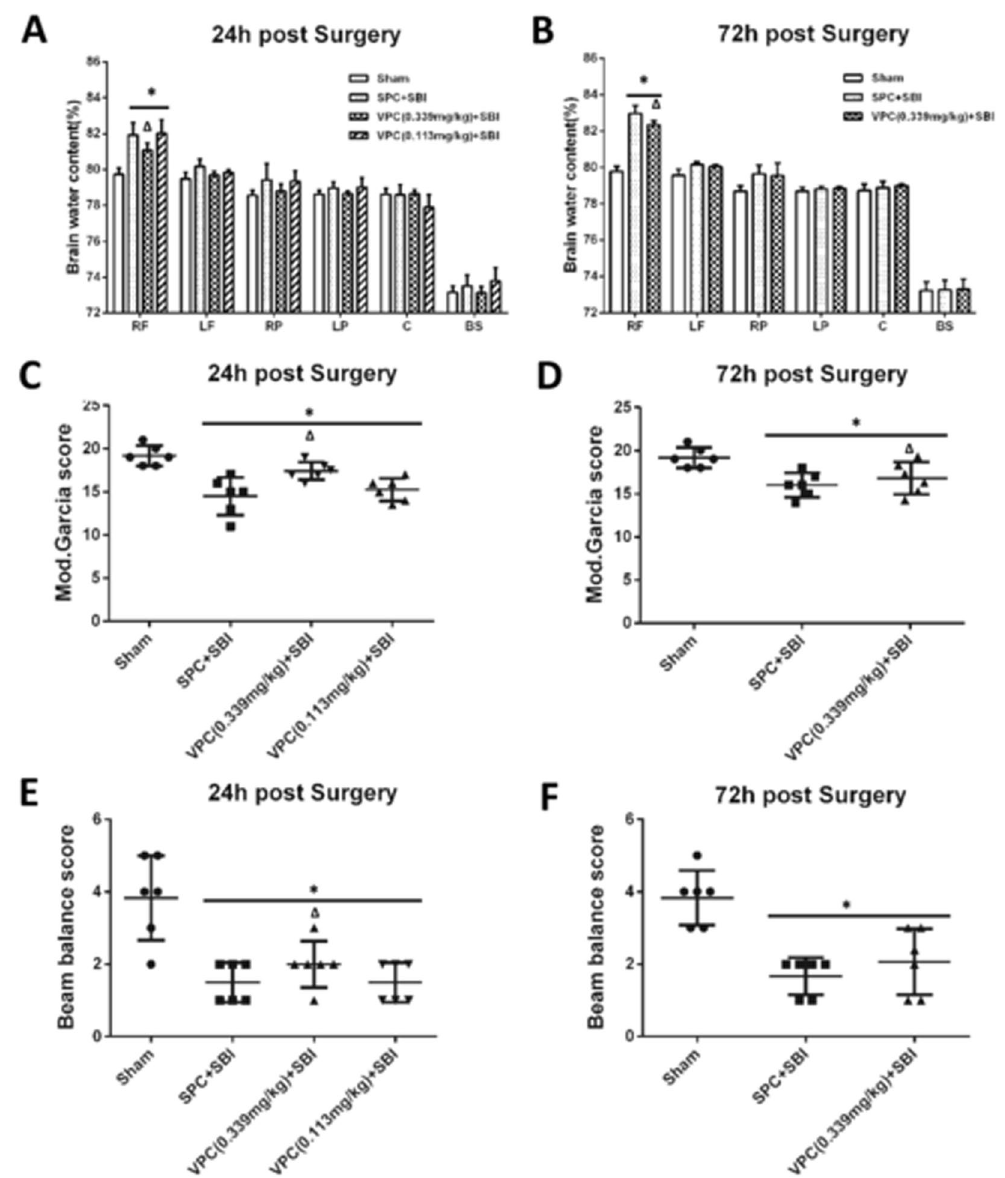
Figure 1. Effects of venom preconditioning (VPC) on brain water content and neurological function 24 h and 72 h after SBI. (A and B) VPC (0.339 mg/kg) decreased brain water content at the right frontal (RF) peri- resection brain tissue 24 h and 72 h after SBI, respectively. (C and D) VPC (0.339 mg/kg) improved modified Garcia neurological score 24 h and 72 h after SBI, respectively. (E) VPC (0.339 mg/kg) improved beam balance neurological score 24 h after SBI. (F) VPC (0.339 mg/kg) showed a trend to improved beam balance score 72 h after SBI. * p < 0.05 vs Sham, ∆ p < 0.05 vs SPC + SBI. Data are shown as mean ± SD. n = 6–8/group. RF = right frontal lobe, LF = left frontal lobe, RP = right parietal lobe, LP = left parietal lobe, C = cerebellum, BS = brain